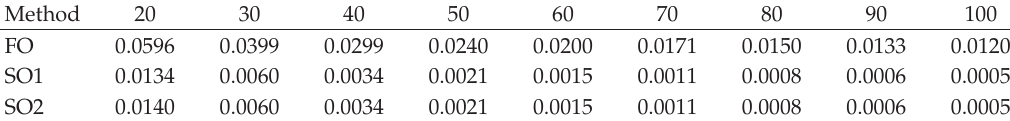
Table 1: Comparison of errors (cid:4) E 0 (cid:5) for approximate solutions.